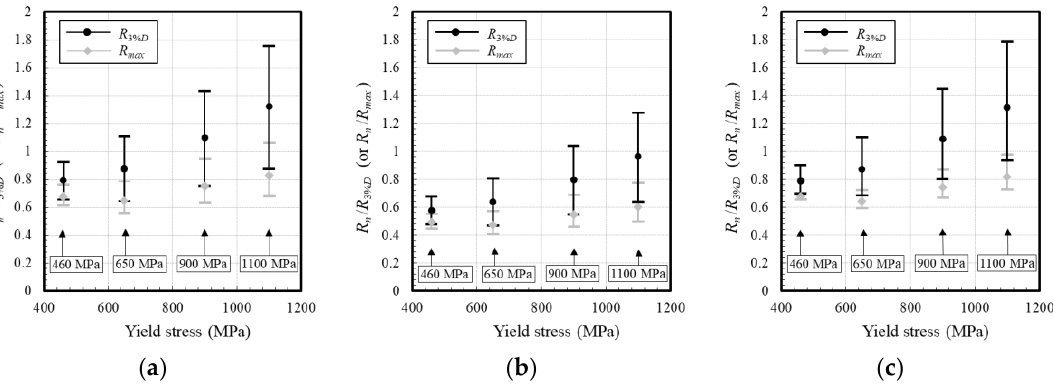
Figure 13. Comparison of design equations with parametric analysis results: ( a ) AISC (2016); ( b ) Eurocode (2005); ( c ) ISO 14346.